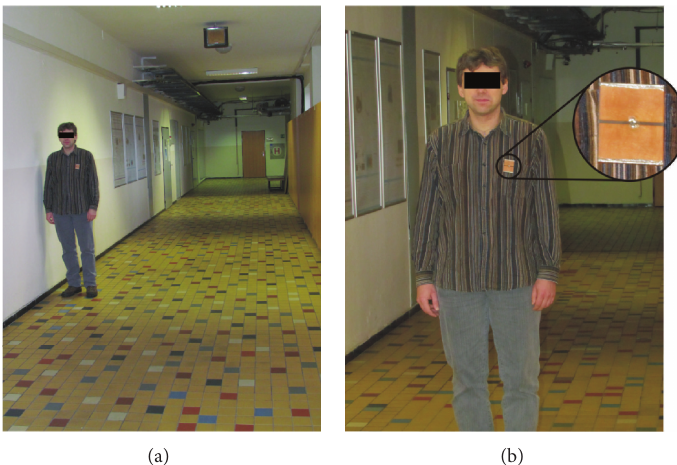
Figure 7: Photograph of a test configuration: general view (a) and details (b) of a person with the chest-fixed TAG in 4m wide corridor.